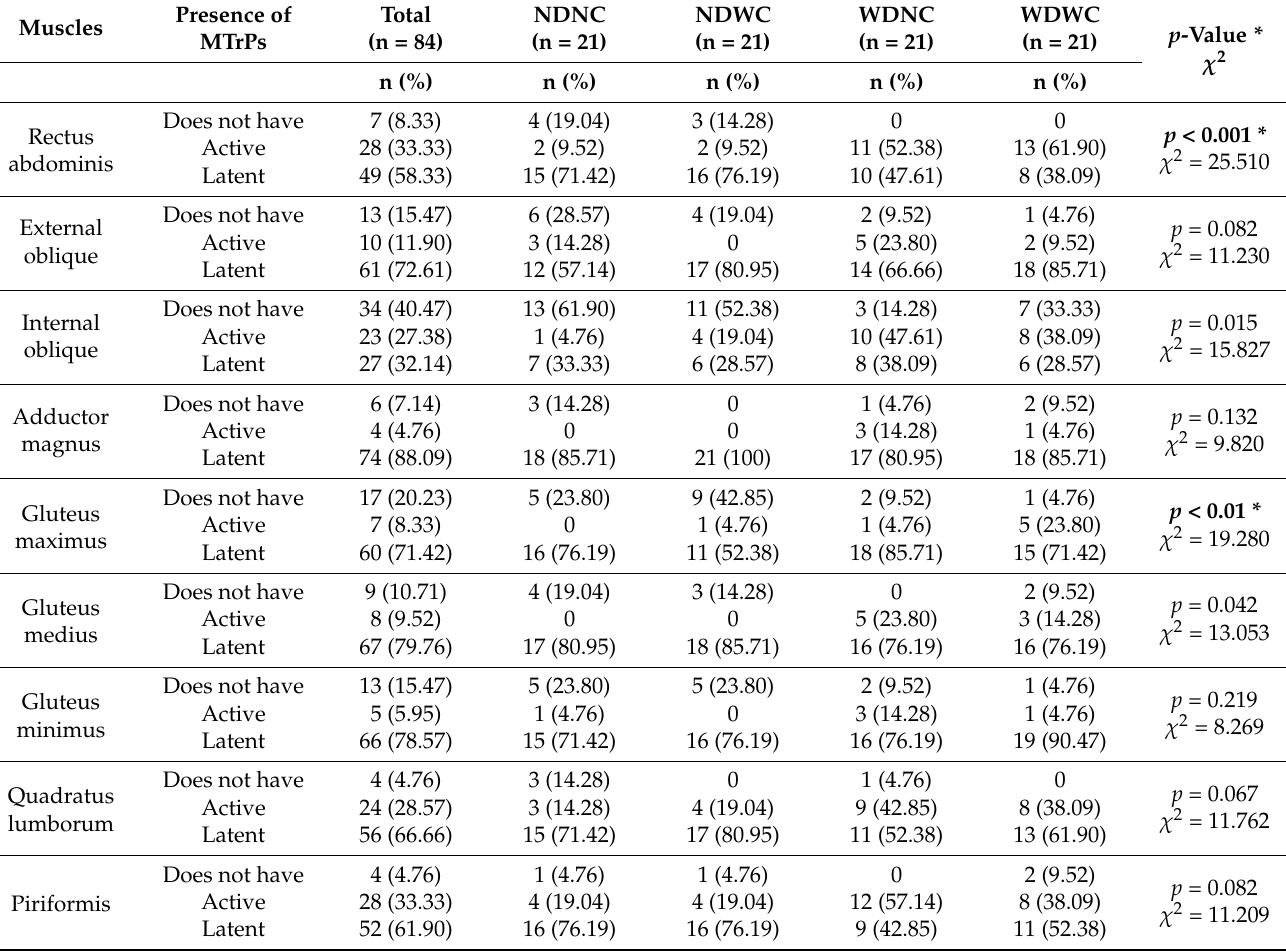
Table 5. Presence of MTrPs in the external musculature evaluated in the menstrual phase.